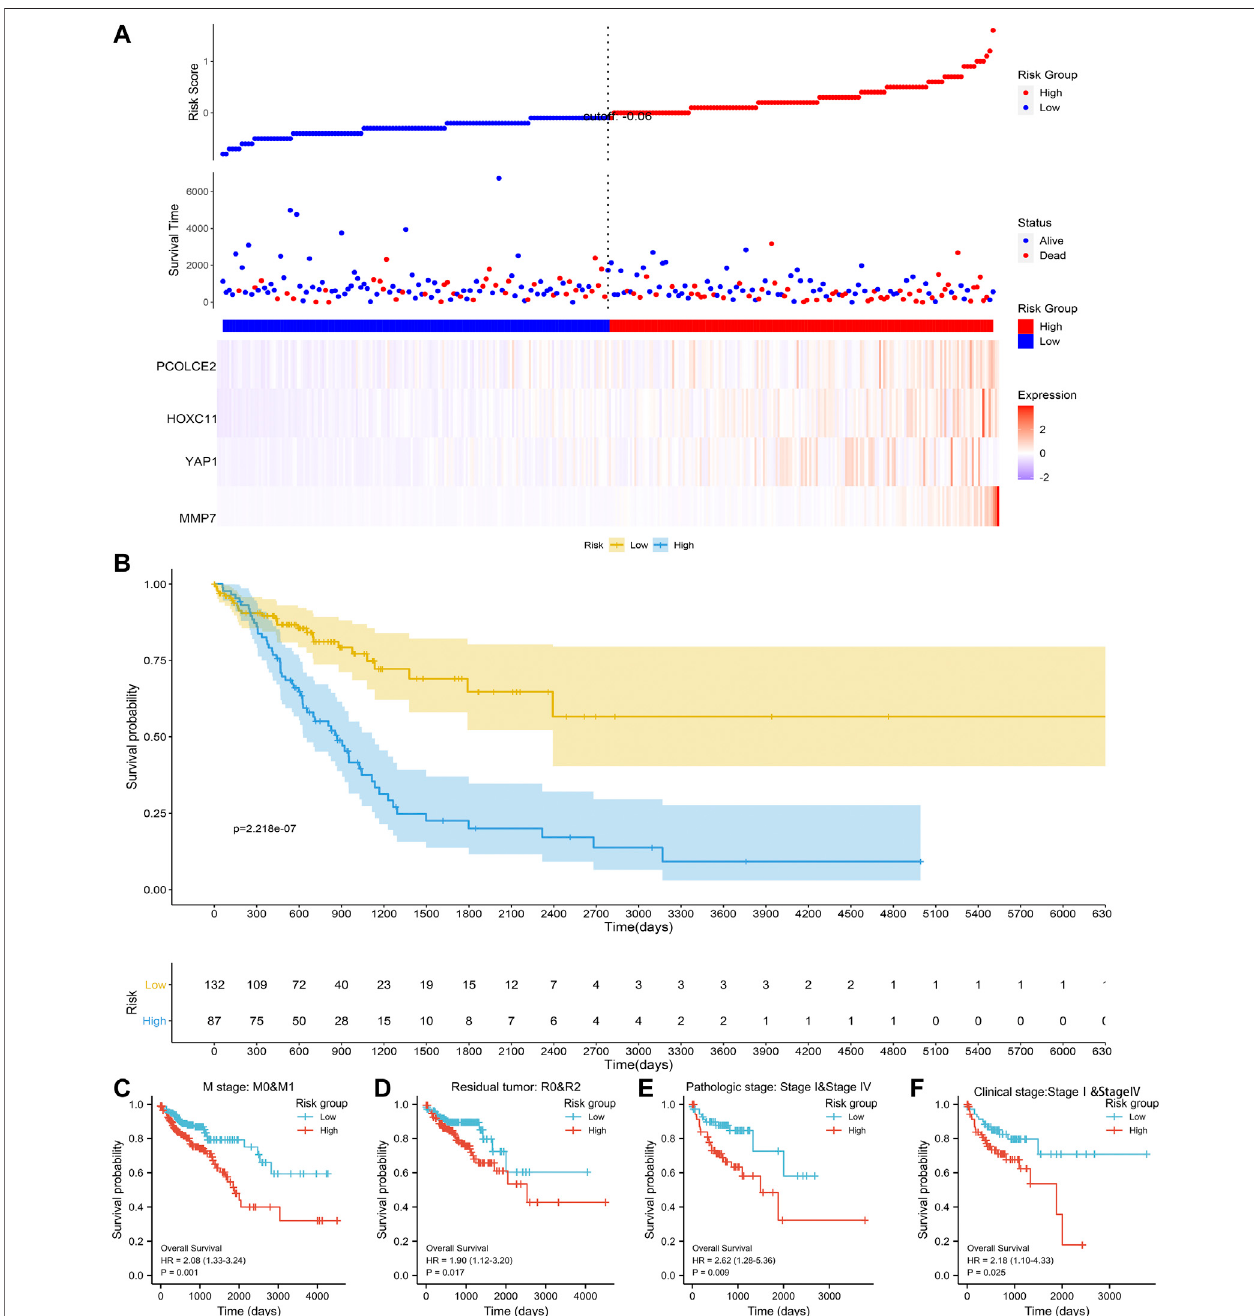
FIGURE5 | Establishmentof therisk signature model. The establishment ofthe risksignaturemodel based on PCOLCE2,YAP1, MMP7, and HOXC11 genein the TCGA (A) ; Comparison of clinical prognosis between high and low risk groups divided using the median risk score in the TCGA (B) ; Comparison of survival prognosis between high and low risk groups by COAD distant metastasis (C) , tumor recurrence (D) , clinical stage (E) , and pathological grade (F) , respectively, p values were statistically signi fi cant.